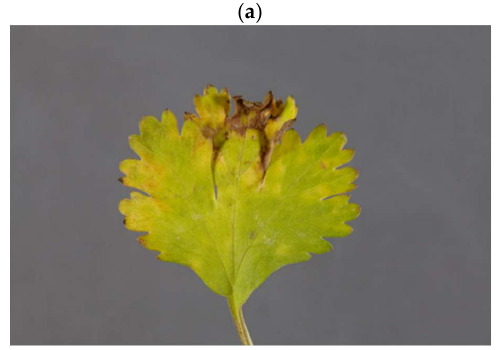
12 of 17 ( d ) Figure 5. Photographs of symptoms in leaves from apiaceous samples intercepted by UK plant health and seeds inspectors; ( a ) Sample 21506527, coriander showing chlorotic spotting; ( b ) Sample 21604167, parsley showing general chlorosis and chlorotic mottle; ( c ) Sample 21625530, coriander showing vein yellowing and chlorotic mottle; ( d ) Sample 21806162, coriander showing vein yellow- ing and chlorotic spotting. Whilst reporting novel sequences to further elucidate the diversity of potyviruses infecting apiaceous species, this study also highlights the remaining knowledge gaps in the evolutionary history of this key group of viruses infecting such a globally important plant family, which includes crops and ecologically important uncultivated species, as mentioned in the introduction. Furthermore, the additional new host record (BWYV in Coriander), new country record (CaTV1 in carrot from Australia) as well as three putative novel viruses further emphasises the need for a greater focus on the Apiaceae virome to understand the pathological and the ecological relationships between its viruses and their respective hosts. 4. Materials and Methods 4.1. Sample Source Preserved samples were from both historical and recent sample collections that lacked sequence data. These represented a range of apiaceous crop and herb species drawn from two sources, as detailed in Table 2. Four samples were taken from UK plant health import interceptions between 2015 – 2018, consisting of either coriander or parsley originating from the Mediterranean region (Cyprus, Israel and Egypt). These samples had been tested by qPCR for the presence of phytoplasma [63] and qRT-PCR for a range of carrot infecting viruses including CtRLV, CMoV, CaTV-1, CtCV-1 and CYLV [31,52], but the results were negative in both studies. Consequently, the samples were retested using HTS to determine the identity of any other viruses that might be present. A further six samples were collected in Australia during surveys for viruses of apiaceous crops in 1998- 2002. These had previously been found to contain the potyviruses ApVY, CeMV or CarVY identified through specific serological testing by ELISA, sometimes accompanied by inoc- ulation to test plants but not by qPCR or sequencing [8,13]. Table 2. Origin of samples and sample descriptions. Sample